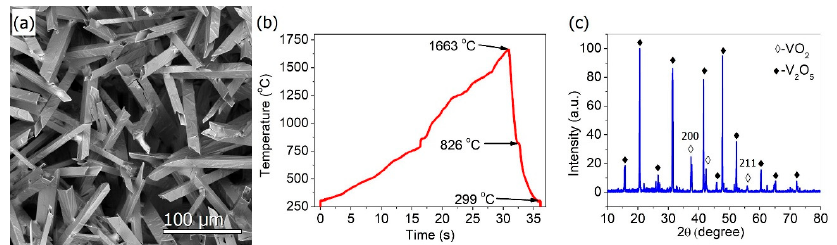
Figure 5. Characteristics of recrystallization product via heating with high peak temperature and cooling rapidly: ( a ) SEM image, ( b ) temperature vs. time curve during recrystallization, and ( c ) XRD pattern.